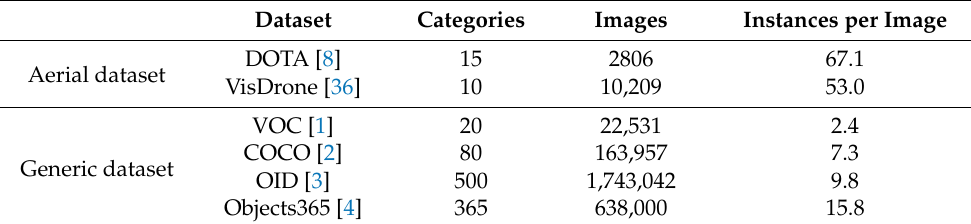
Table 2. Comparison between generic datasets and aerial datasets. Dataset Categories Images Instances per